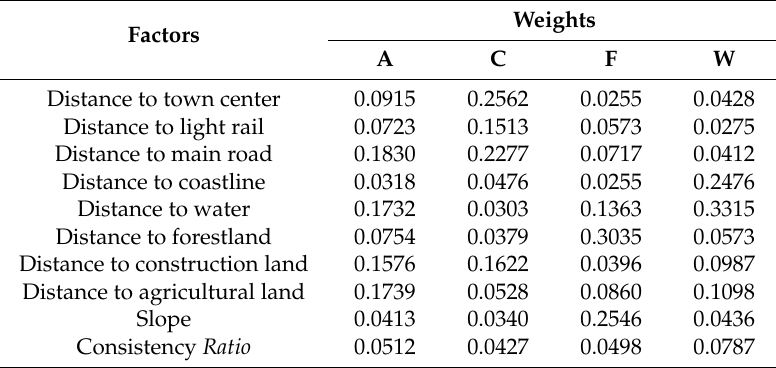
Table 3. Land use transition probability matrix and area demand.